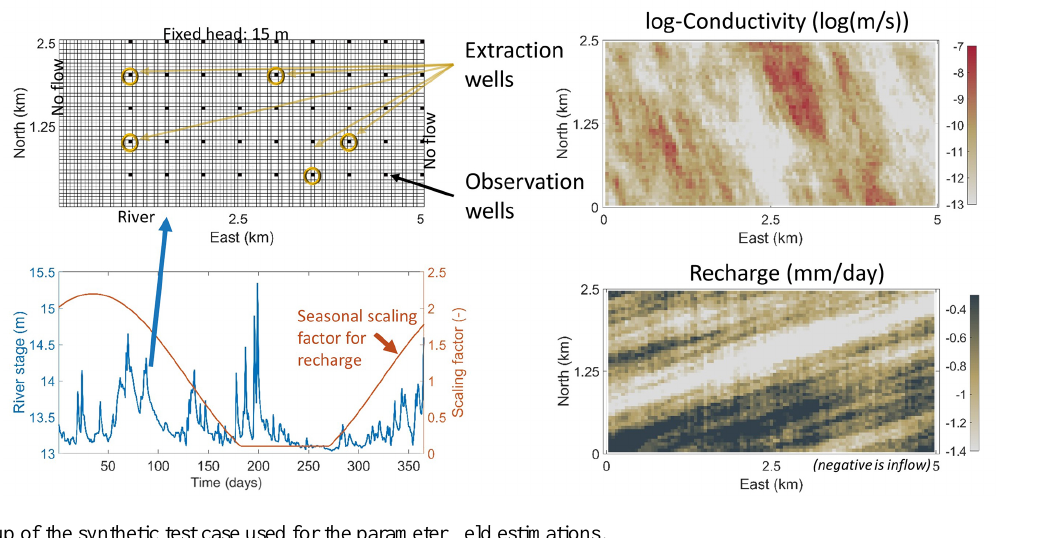
Figure 2. Setup of the synthetic test case used for the parameter field estimations.